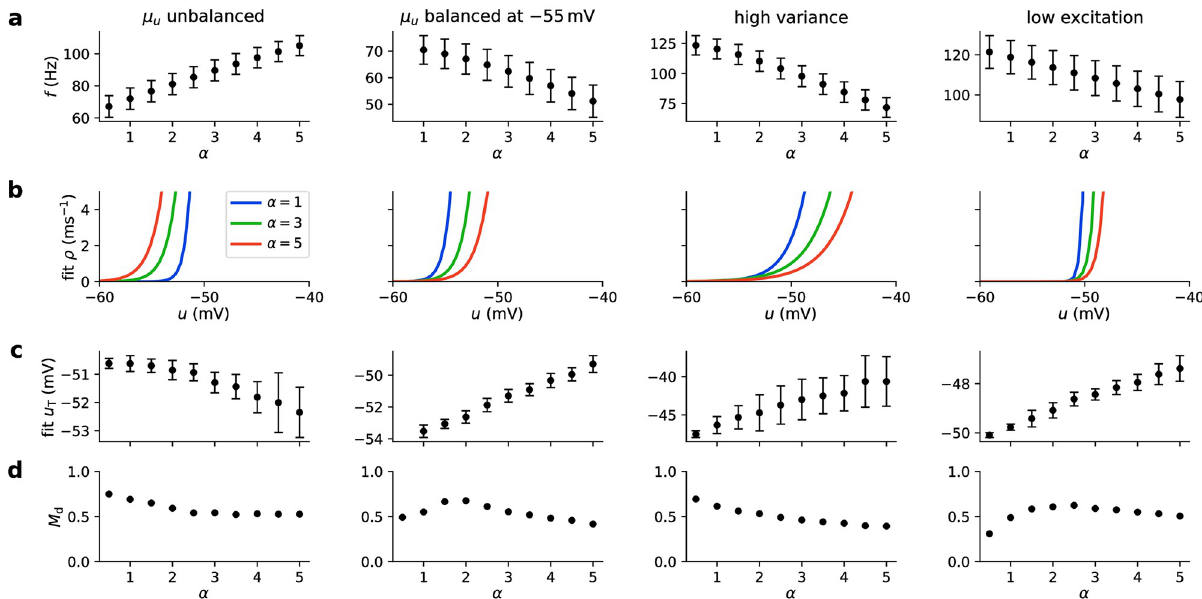
Fig 9. Details of stochastic model fitting. (a) Firing rate in response to stimulus used for fitting. Dots denote mean, fliers standard deviation over N = 50 independent runs. (b) Result of fitting the stochastic model (see Eq 12) for different values of α . The parameters of ρ (including the temperature T , Fig 5e) were obtained by averaging the results of N = 50 independent fits. (c) Soft threshold values resulting from fitting. (d) Quality of fit as described by M d criterion (see Methods), measuring match of firing intensities of LIF model and stochastic models resulting from fitting. The fit models reproduce spiking behavior reasonably well ( M d = 1 indicates a perfect match, M d = 0 indicates no overlap of PSTHs).